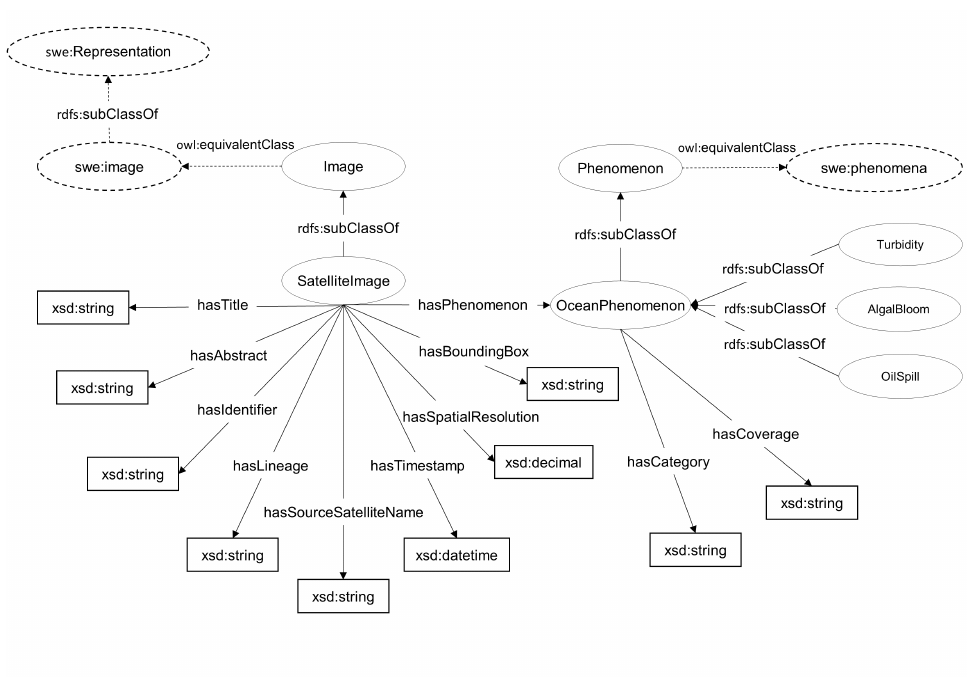
Figure 1. SeMaRe ontology. The namespace for SeMaRe classes and properties ( seo ) is omitted for brevity. Dashed classes and properties represent external objects, specifically, SWEET classes and their relation with the SeMaRe